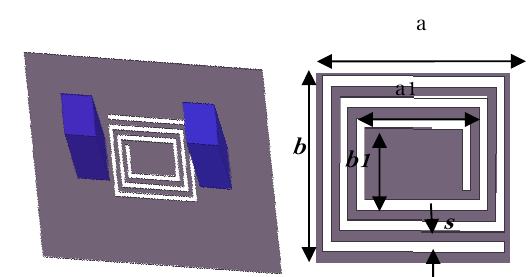
Figure 6: The two elements of the SDRA antenna array with DGS.